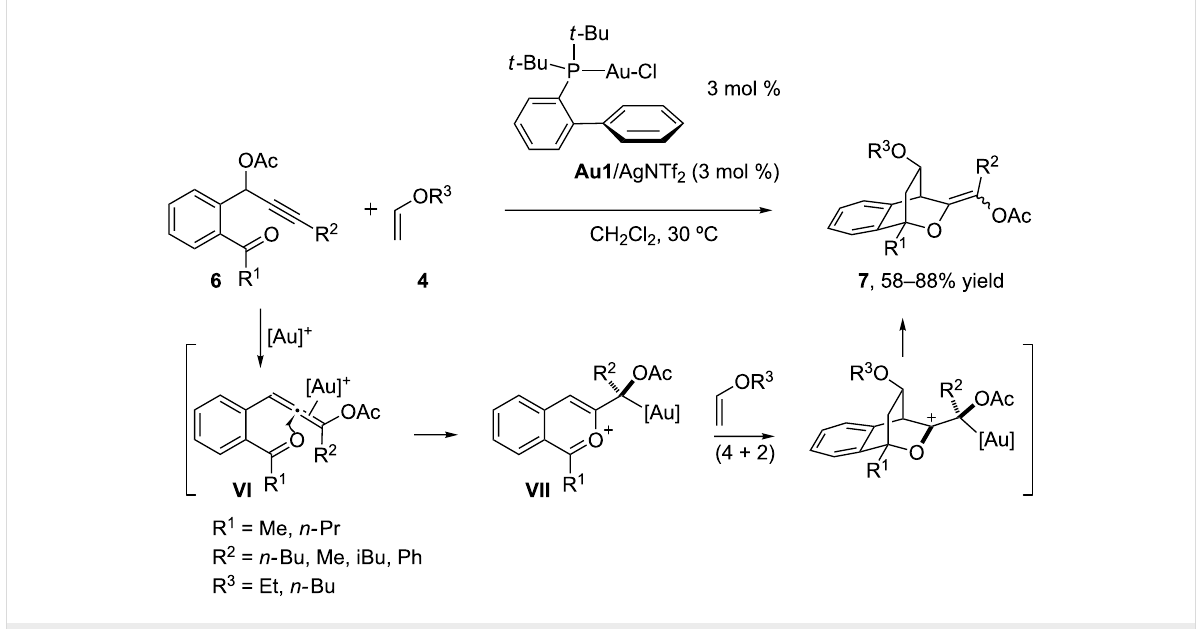
Scheme 3: Stereocontrolled oxacyclization/(4 + 2)-cycloaddition cascade of ketone–allene substrates [43].